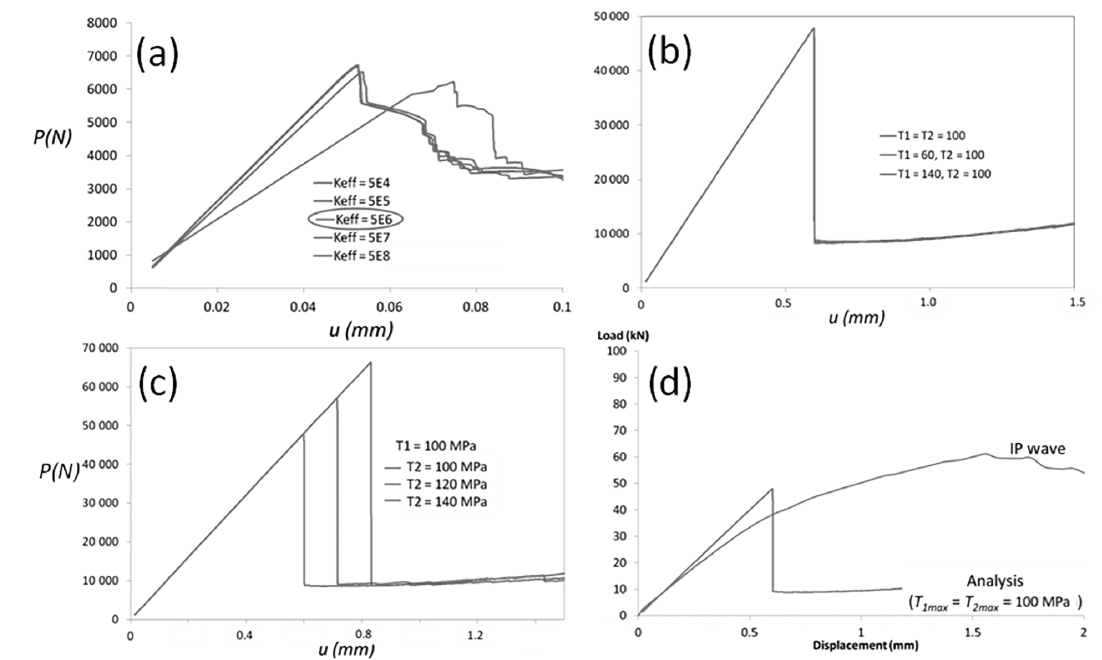
Figure 5. Results of parametric studies to find the cohesive element: (a) effective stiffness, K eff ; (b) peak Mode I traction, T 1max ; (c) peak Mode II traction, T 2max ; and (d) confirmation of peak